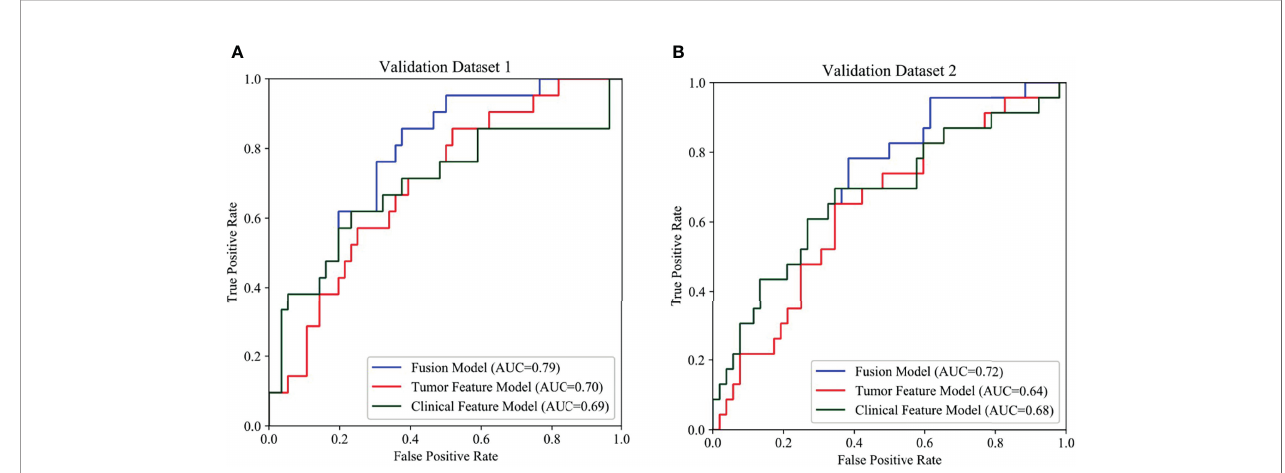
FIGURE 4 | Comparison of prediction performance among the three models using different features. In the ROCs, the blue, red, green curves show the models based on fusion features, tumor features and clinical features, respectively. (A) ROCs of internal validation set, (B) ROCs of external validation